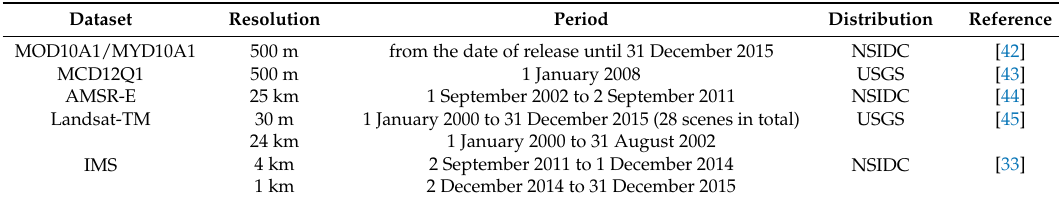
Table 1. The information of remote sensing